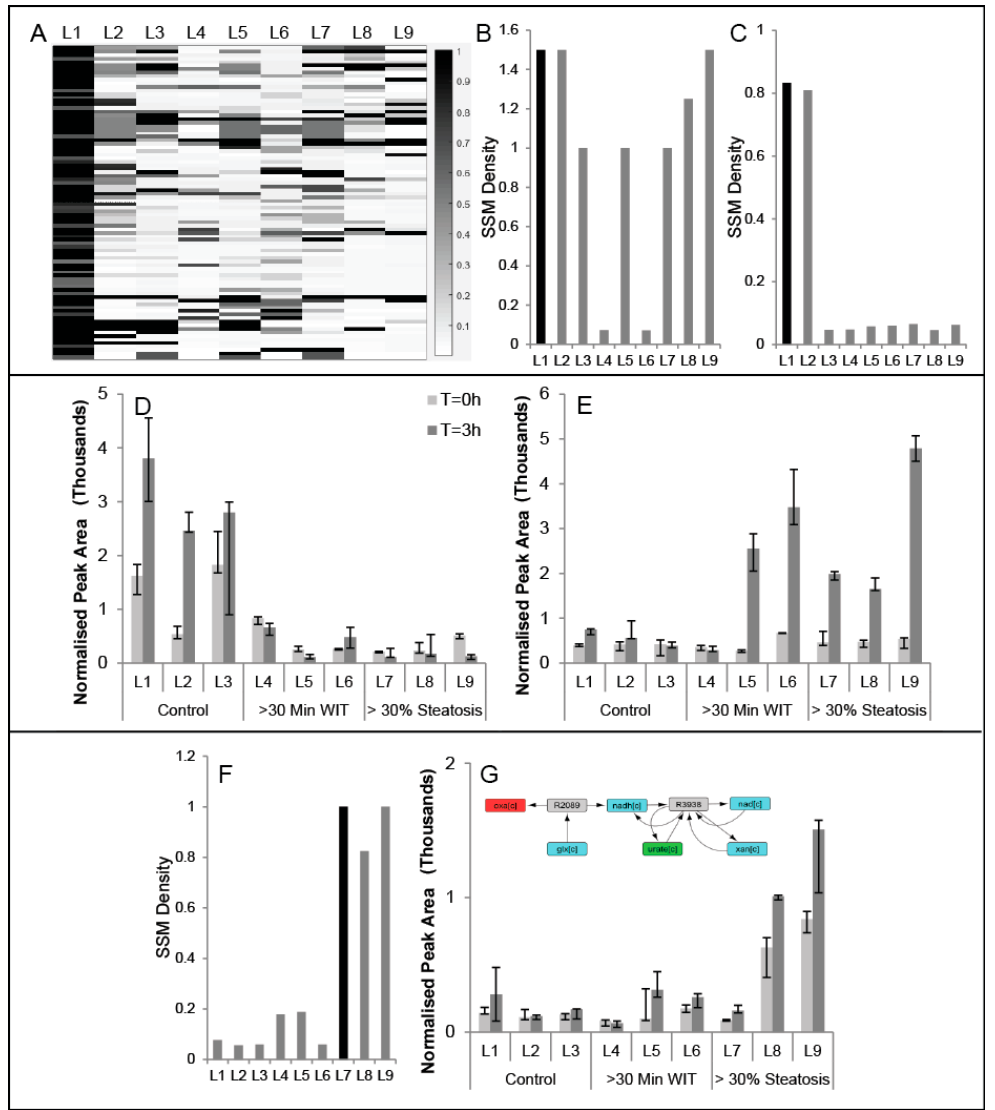
Figure 4. ( A ) heatmap where each row represents a Liver 1 module for which the SSM density is greater than 0.5 and each column represents each of the nine livers. The color entry in the